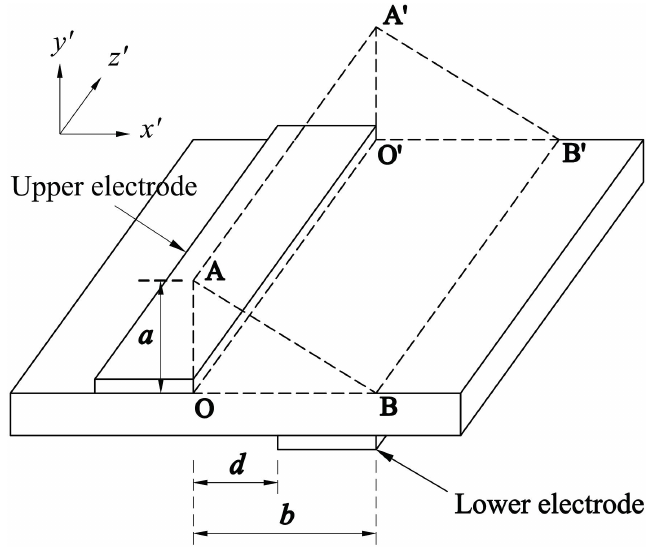
Figure 1. Plasma active region in the phenomenological model.